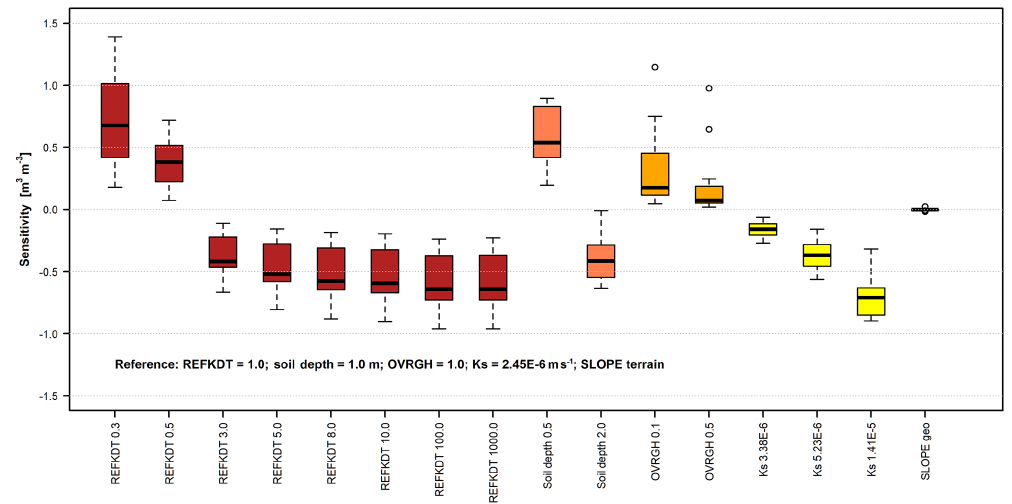
Figure 3. Boxplots of the sensitivity of the modelled streamflow to perturbations ( x axis) in REFKDT (infiltration partitioning scaling coefficient), soil depth, OVRGH (overland roughness factor), K s (saturated hydraulic conductivity) and SLOPE geo (deep-drainage parameter defined based on slope terrain and geology) relative to a defined reference scenario (SLOPE terrain represents the slope parameter defined based on slope terrain only, as in Silver et al.,